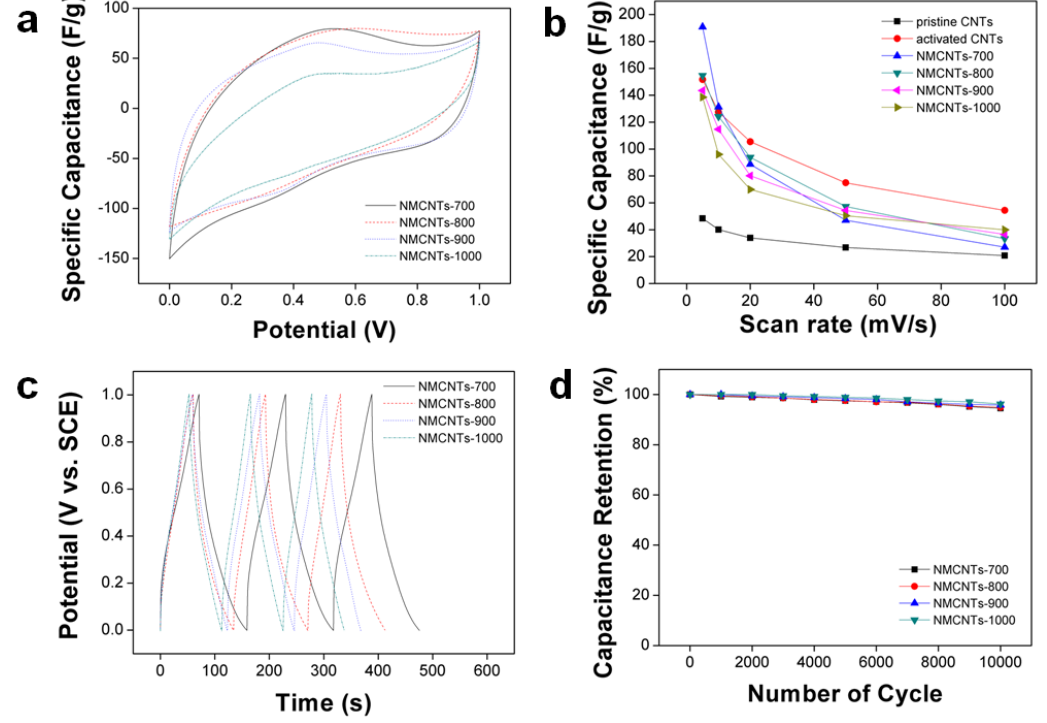
SO aqueous solution; ( b ) capacitance of the cells 2 4 SO aqueous 2 4